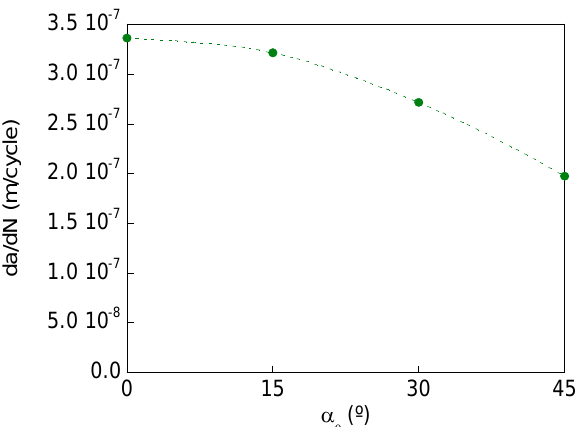
Figure 4: Fatigue crack growth rate as a function of the deflection angle of the